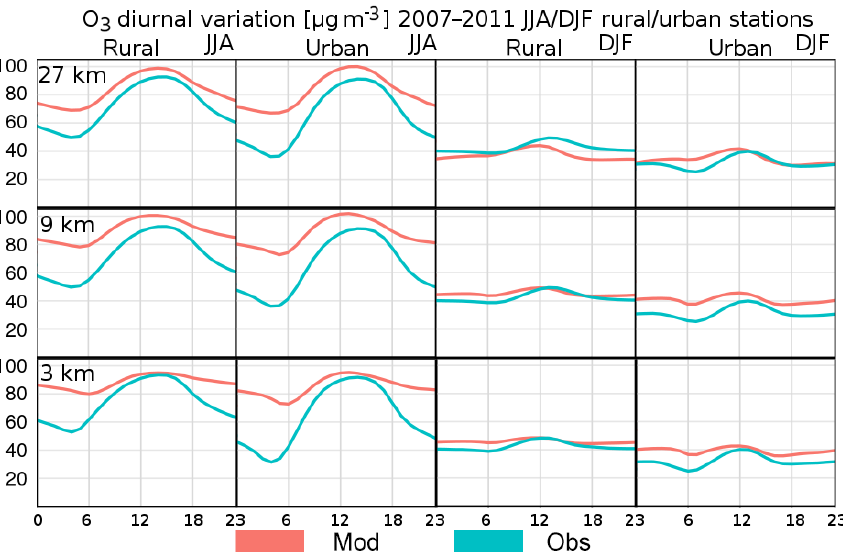
Figure 4. Comparison of average diurnal cycles of ozone with measurements µgm − 3 for JJA (columns 1 and 2) and DJF (columns 3 and 4) for rural and urban background stations for the three domains (27, 9 and 3km, from top to bottom): model (red) and observation